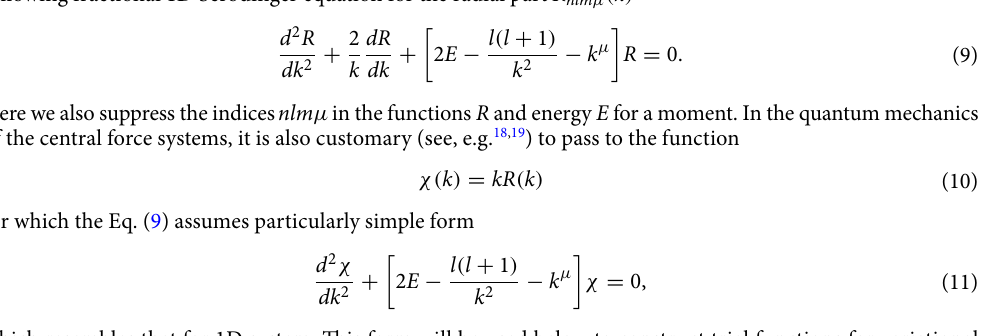
Figure 1. Potential in the Schrödinger equation (9) at l (legend in ( a )). Mind the different vertical scales in ( a,b